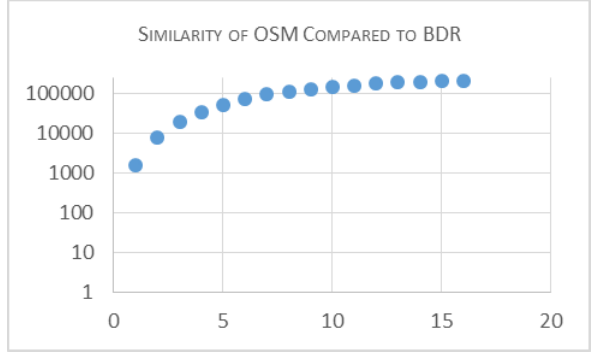
Figure 4. Similarity of OSM compared to